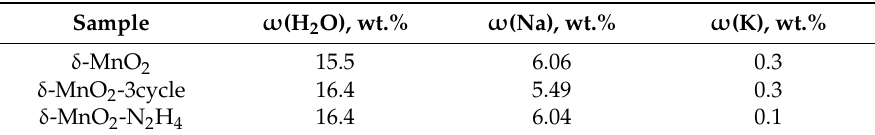
Table 2. Impurities contents in the studied